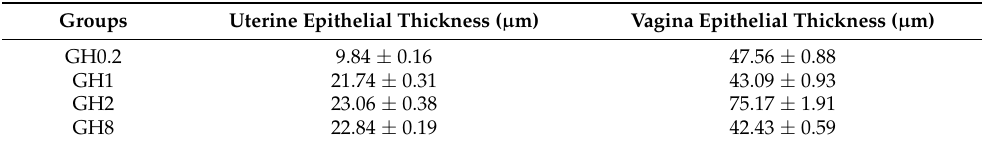
Table 6. Measurements of the uterine and vaginal epithelial thickness following 14 days of Gelam honey (GH) administration to Sprague–Dawley rats ( n = 4/group).